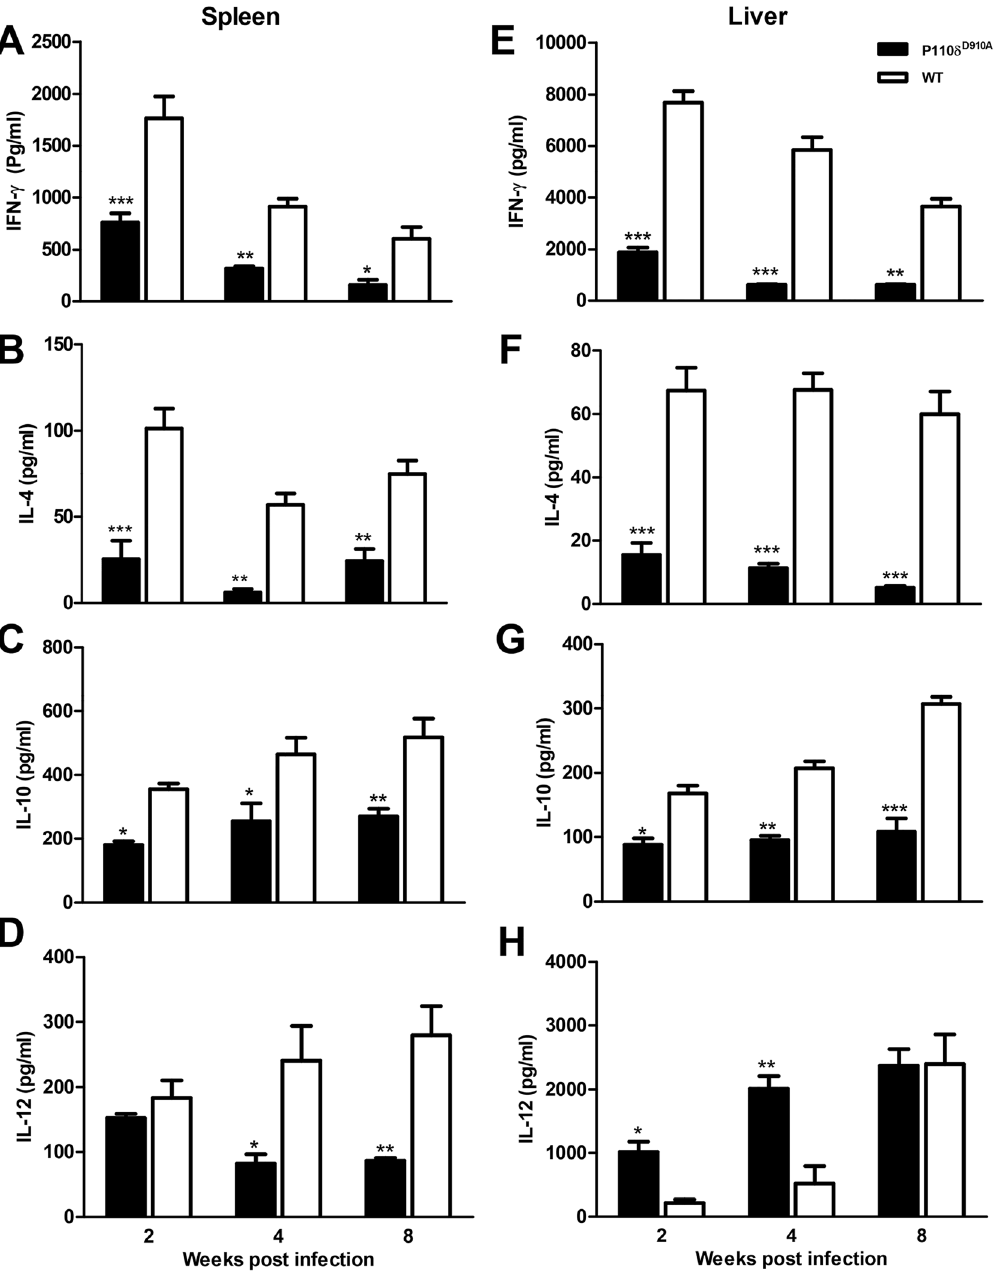
Figure 2. Impaired cytokine production by spleen and liver lymphocytes from L.donovani -infected highly resistant p110 d D910A mice. At the indicated times after infection, spleen and liver lymphocytes from WT and p110 d D910A mice were cultured in vitro in the presence of L. donovani antigen for 72 hrs and the culture supernatant fluids were assayed for cytokines by Flowcytomix array. Shown are the splenic values for IFN- c (A), IL-4 (B), IL-10 (C) and IL-12 (D) and liver values for IFN- c (E), IL-4 (F), IL-10 (G) and IL-12 (H) at different times post-infection. Results are representative of 3 independent experiments (n = 4 mice per group) with similar results. Error bars, + / 2 SEM; *, p , 0.05; **, p , 0.01; ***, p , 0.001; ND, Not